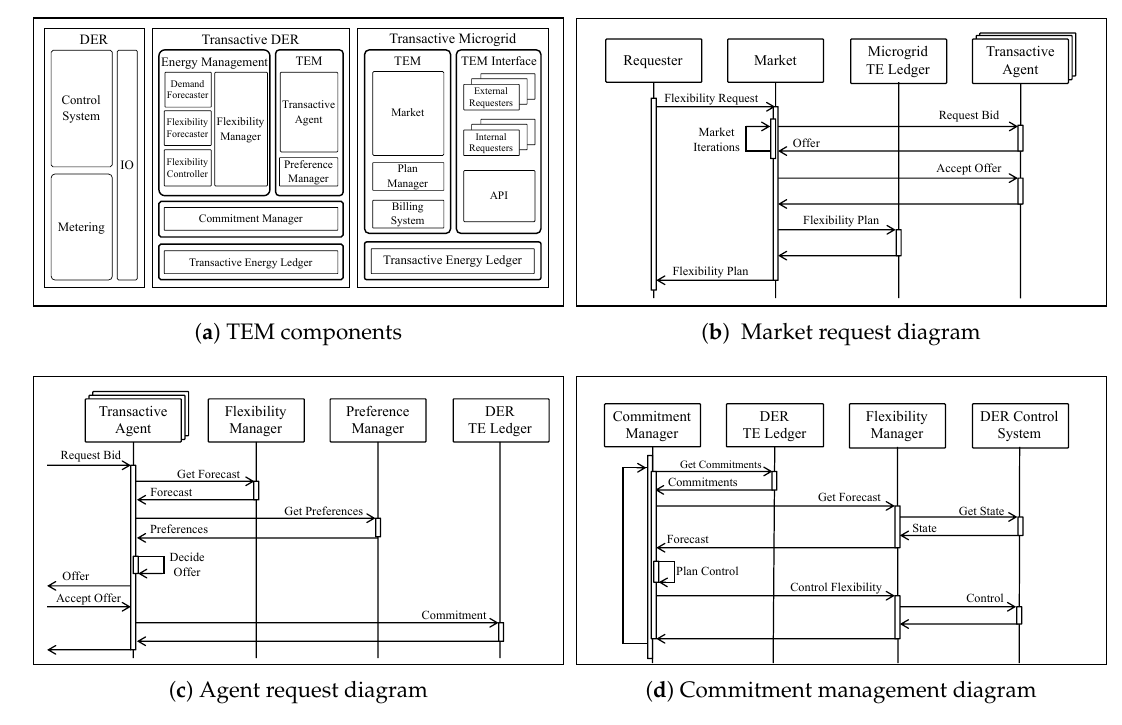
Figure 7. TEM implementation